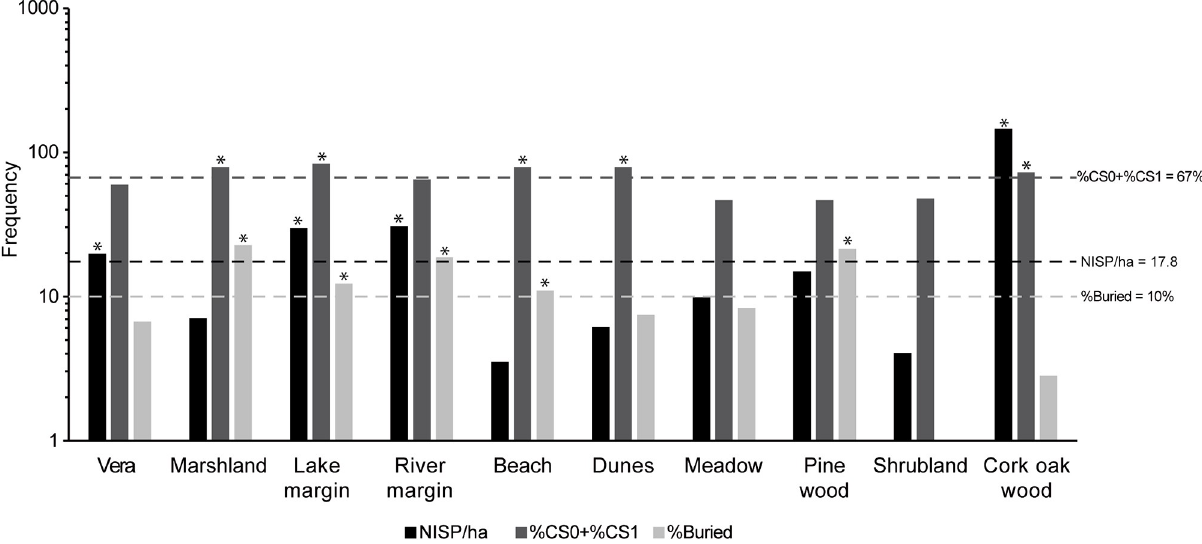
Fig 7. Biostratinomic taphonomic variables that favor the formation of a fossiliferous site. NISP/ha = Number of Identified Specimens per hectare; CS = Completeness stage (see text for the meaning of each stage). Dashed lines mark the average values for DNP. Asterisks mark the instances in which habitat values exceed the DNP average